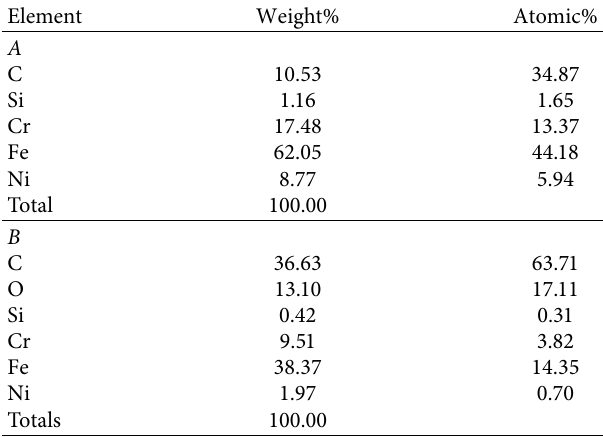
Figure 1: SEM image of iron-based alloy powder particles: (a) no rosin added and (b) rosin added. Table 1: Levels of different elements in the ion-based alloy powder particles (a) before and (b) after addition of rosin.